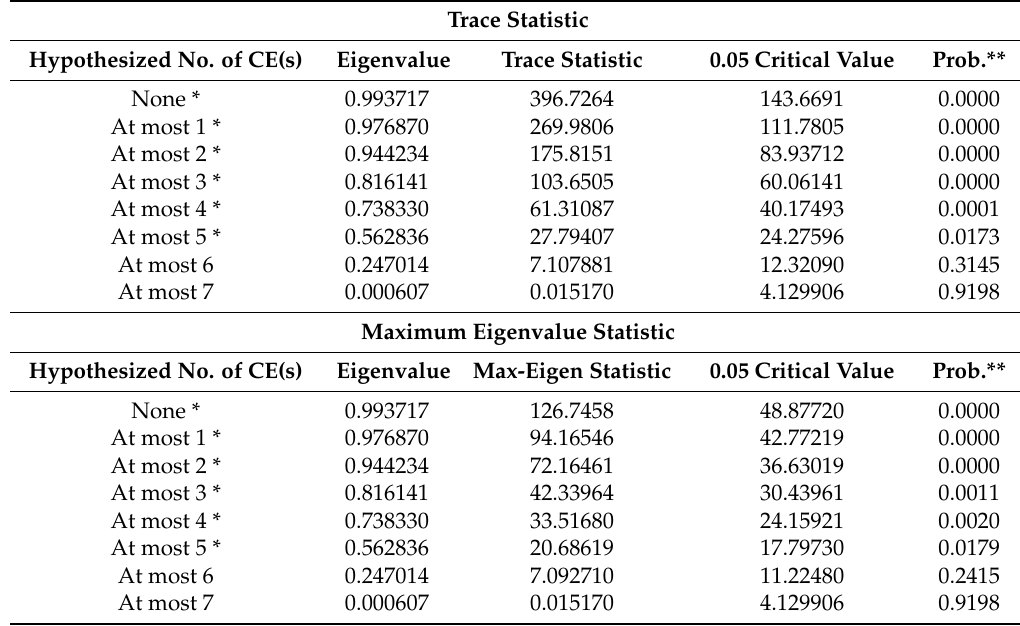
Table 4. Results of the Johansen Cointegration test Using Trace Statistic and Maximum Eigenvalues.